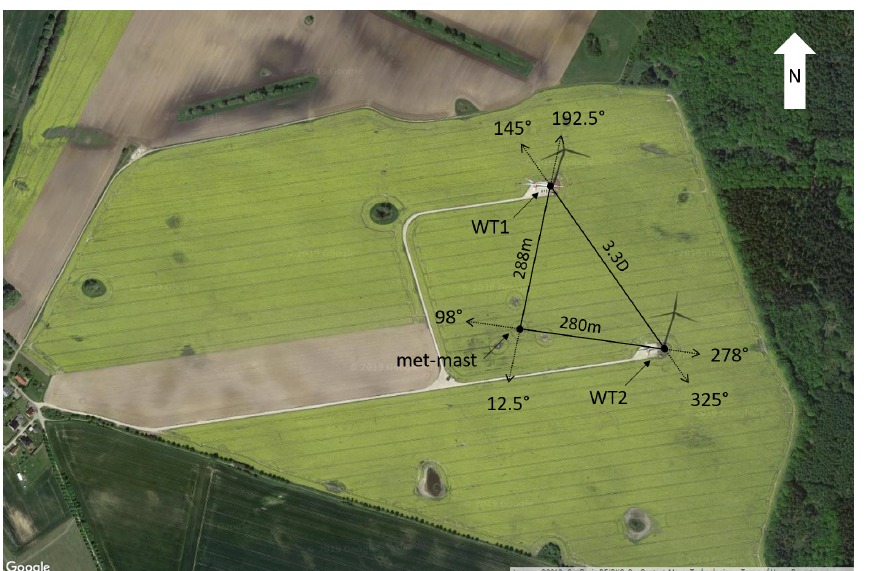
Figure 2. Satellite image with WT1, WT2, and met mast, including waking directions and distances (© Google Maps).